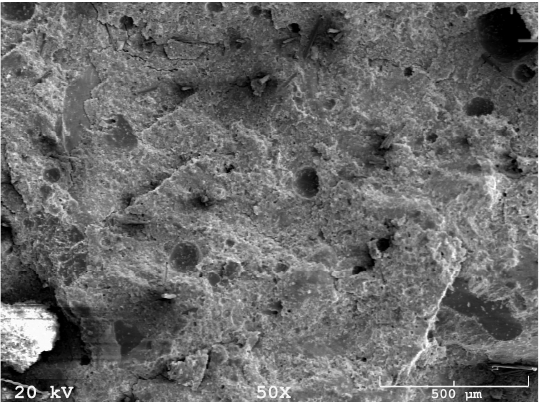
Figure 4. SEM image of geopolymer G 200–900 µm at 50× magnification.